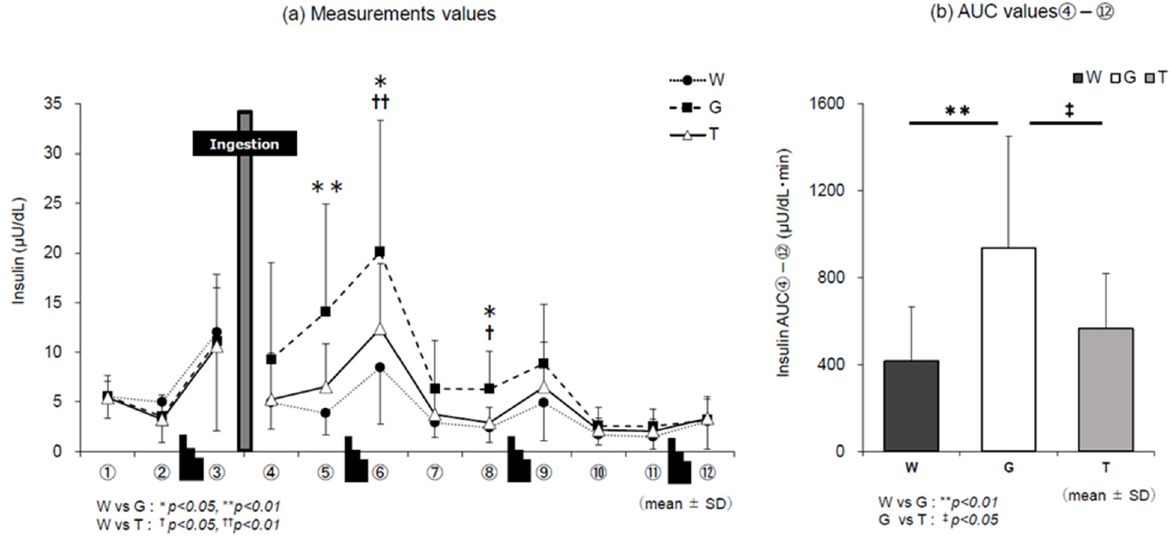
Figure 5. Changes in insulin levels for each trial. W—water; G—glucose; T—trehalose. Changes in insulin levels in each trial (water (W), glucose (G), trehalose (T)). Comparison between ( a ) measurements and ( b ) area under the curve (AUC) values ④ – ⑫ of each trial ( n = 12). W vs. G: * p < 0.05, ** p < 0.01; W vs. T: † p < 0.05 , †† p < 0.01; G vs. T: ‡ p < 0.05.